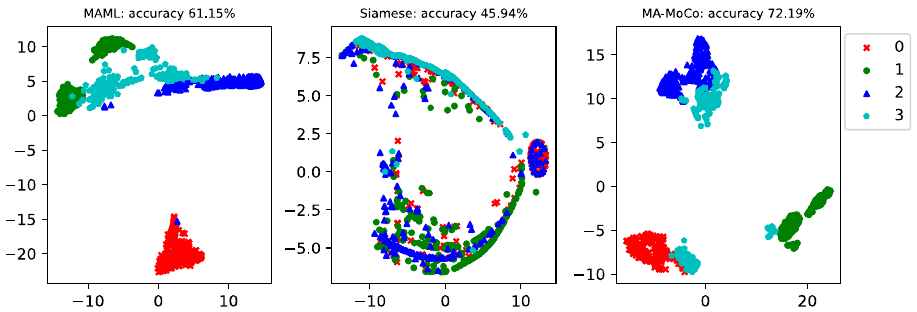
Figure 3. A 4-way 1-shot diagnosis of the generator bearing data when the training set of each class has only 5 fault samples.